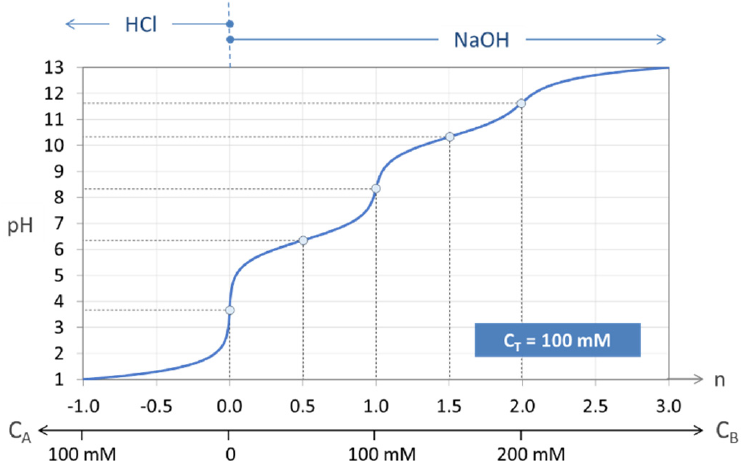
Figure 7. Titration curve n = n(pH) of the “closed” carbonate system (100 mM H 2 CO 3 ).